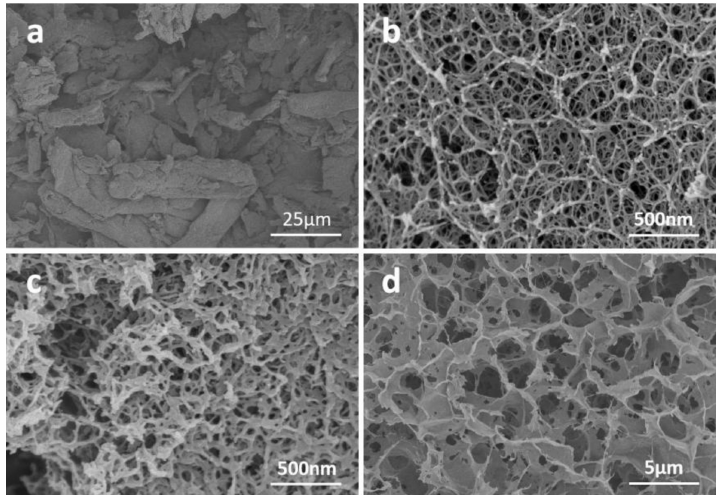
Figure 6. SEM images of ( a ) raw cellulose powder and cellulose aerogels prepared under different conditions: ( b ) ionic liquids & freeze-drying, ( c ) NaOH/urea solutions & supercritical drying, and ( d ) NaOH/urea solutions &